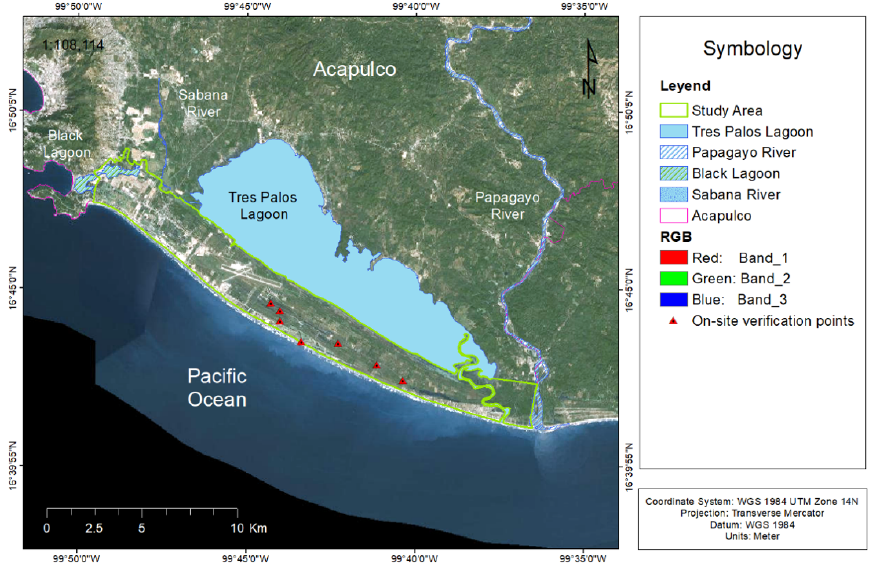
Figure 5. In red, the seven height measurements made with GPS are indicated to validate the alti- metric information of the digital elevation model. altimetric information of the digital elevation